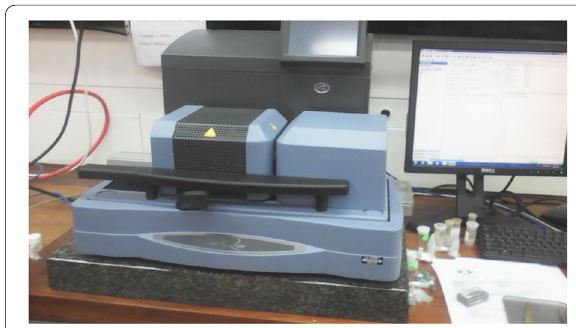
Fig. 4 Photograph of DTA-TGA equipment. (TA Instruments)